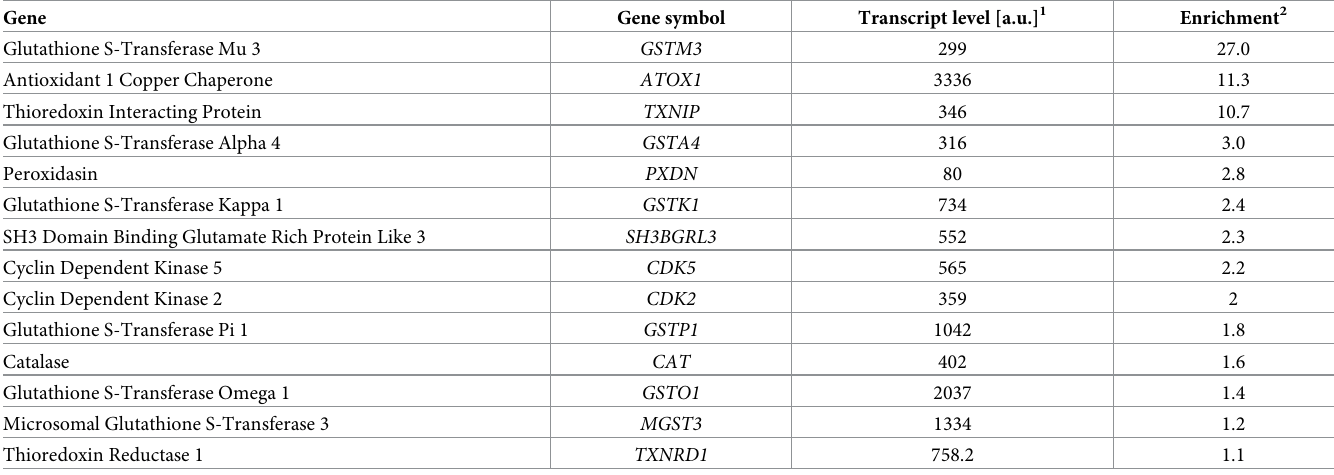
Table 2. Genes with higher expression in Me45 than in HCT116 cells (microarray data).